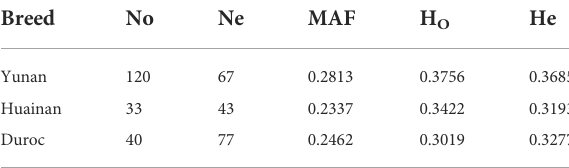
TABLE 1 Summary of population genetic diversity indexes.